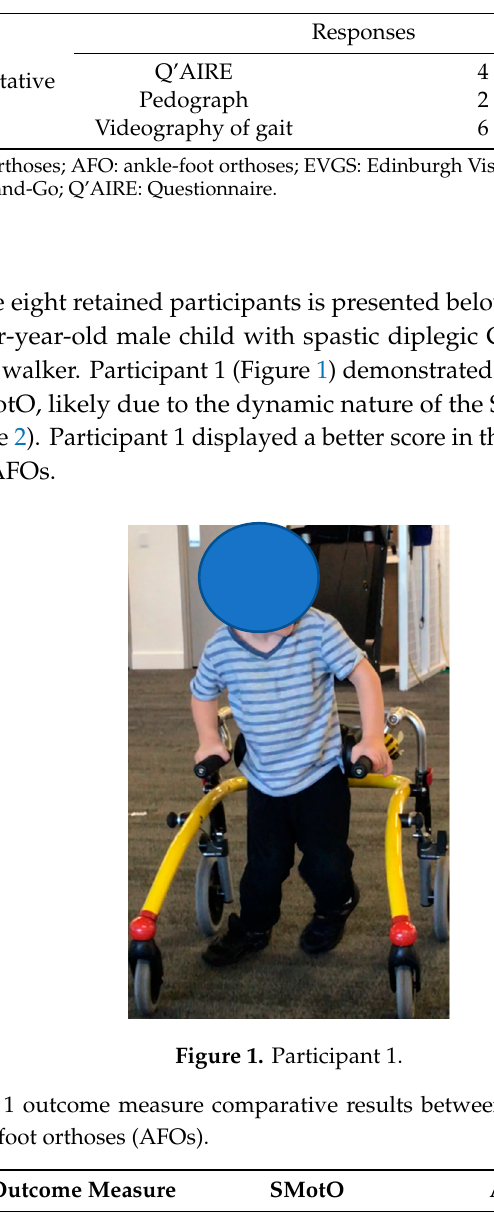
Table 1. Participant quantitative and qualitative outcome measure responses.